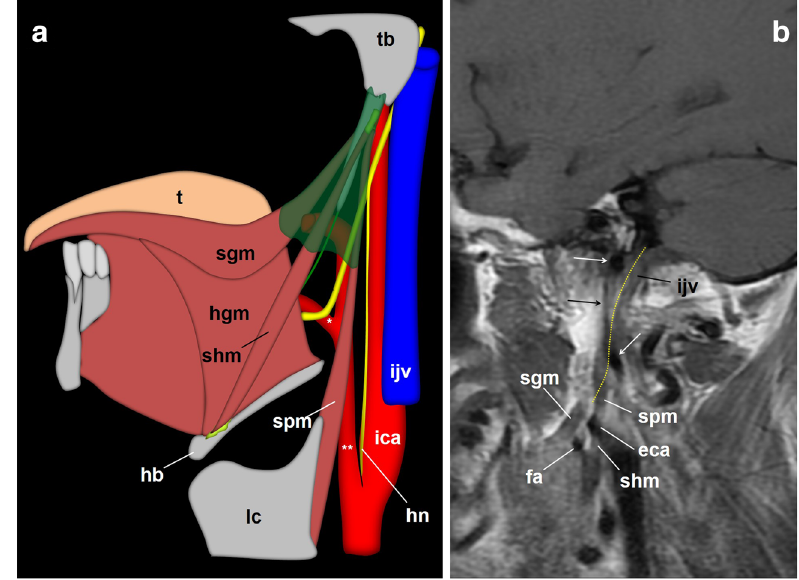
Fig. 9 The glossopharyngeal nerve, cervical portion. a Schematic drawings that depict the glossopharyngeal nerve at the styloid pyramid and its oropharynx end. Once the Hering ’ s nerve (hn) has left the IX cranial nerve, the glossopharyngeal nerve enters a muscular tripod that consistsofthreestyloidmuscles and a fascia(shadedin green): the styloid pyramid. Within the pyramid, the glossopharyngeal nerve (arrowhead) usually runs in a triangular plane limited by the facial artery (*), the external carotid artery (**) and the styloglossus muscle (sgm). When